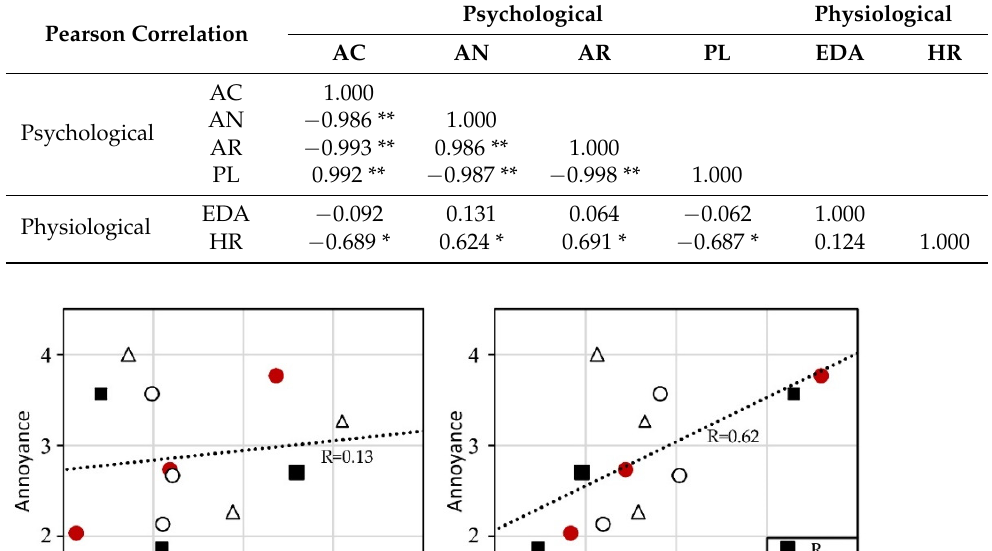
Table 3. Correlation analysis between psychological and physiological responses. * and ** represent significant correlations at 0.05 and 0.01 levels, respectively.